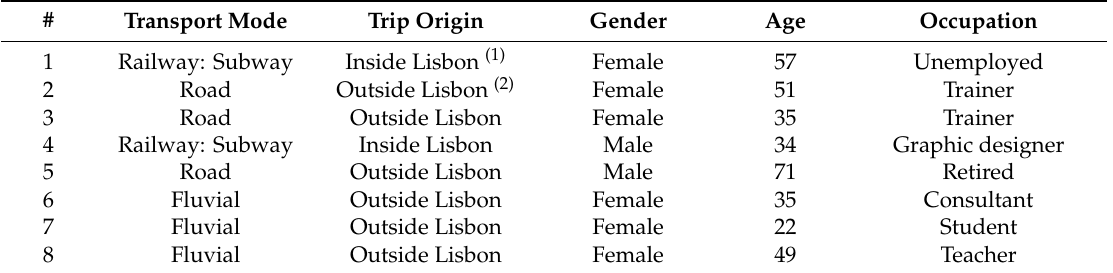
Table A1. Description of participants in ethnographic